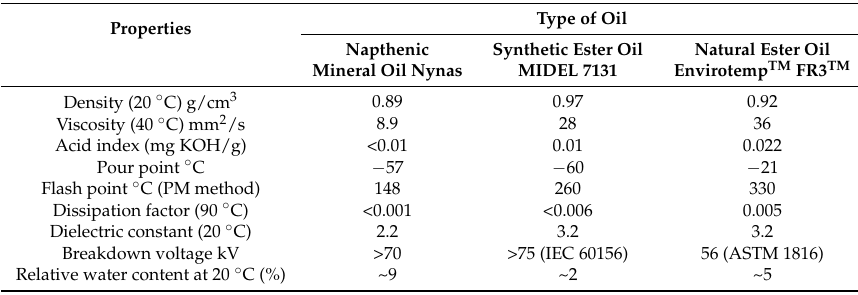
Table 1. Properties of tested oils. The flash point is measured according to Pensky-Martens (PM) closed-cup method according to ASTM